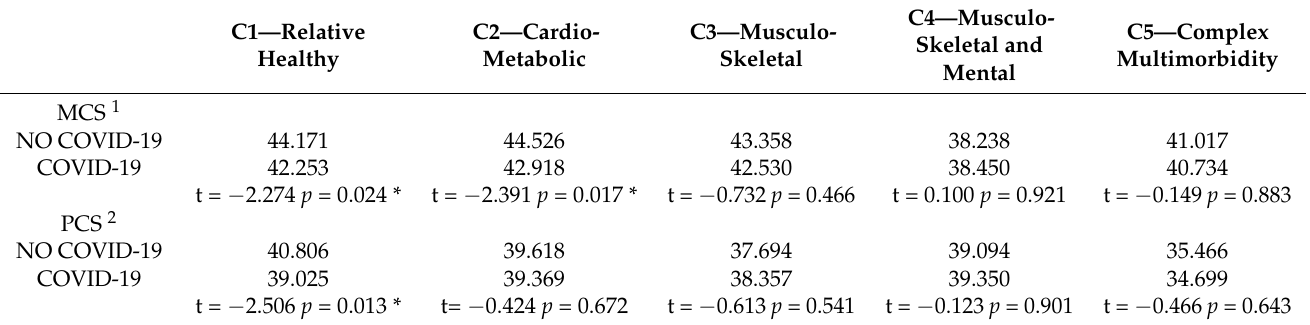
Table 2. Mental and Physical Health among Patterns depending on COVID-19.